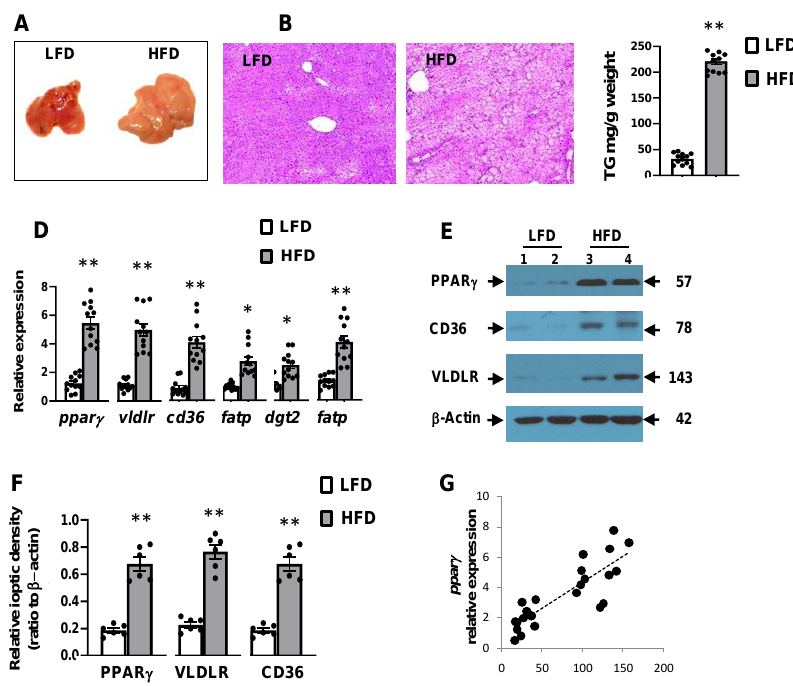
Figure 1. Effects of high-fat diet on hepatic lipids and gene expression. ( A ) Representative photos of gross liver and ( B ) microscopic hematoxilin and eosin (H&E) stained sections. ( C ) Hepatic TG content ( n = 12), ( D ) levels of mRNA ( n = 12), ( E ) representative blots, and ( F ) means of optic density of protein bands ( n = 6). ( G ) Association between hepatic triglyceride content and ppar γ expression. Mice were fed low fat diet (LFD) and high-fat diet (HFD) for 12 weeks. Hepatic triglycerides were measured by enzymatic assay. Results are presented as Mean ± SEM. Statistical difference was assessed with unpaired t -test, differently from LFD with ** p < 0.01. The abundance of mRNA was investigated with qPCR, differently from LFD with ** p < 0.01 and * p < 0.05. Protein levels were examined by Western blotting and data of optical density were arbitrary units and were obtained after scans of bands, as described in Methods. Different from LFD, ** p < 0.01.